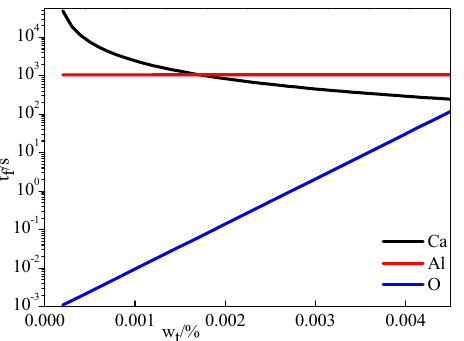
Figure 9. Effects of solute element content in molten steel on the time of complete modification of CA inclusions into C 12 A 7.